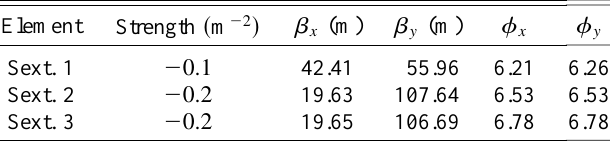
Fig. 1 the Fourier spectrum of the horizontal motion of the